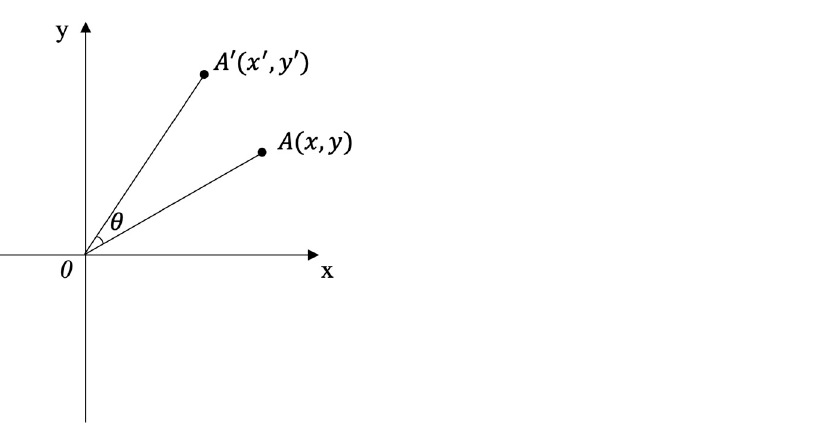
Figure 4. A description of the direction adjustment function. The direction adjustment function is a matrix form of the rotation relationship of A and A (cid:48) . After direction adjustment, the parameters (Formulas (6) to (10)) in the wave potential energy equation and the wave correction equation have multidirectional properties. ϕ g represents gravitational potential energy, where Z is the 3 × 3 template where the central pixel is located, I ( i (cid:48) , j (cid:48) ) is the gray value of the central pixel of the template, g ( i (cid:48) , j (cid:48) ) is the Gaussian weighting function, and MAX is the maximum gray value of the whole image. ϕ v represents kinetic energy, v is central velocity, v q is wavefront velocity, σ is a regulation factor, and the function of wavefront velocity v q is to eliminate speckle noise near the boundary line, which leads to a sharp increase in kinetic energy. The Q template is a 3 × 2 template before the center pixel, and v q is the normalized difference value of adjacent pixels in the Q template. The function of regulation factor σ is to prevent the large area and high gray value area in the image from causing too much kinetic energy and over-segmentation of boundary areas. σ controls the influence of the gray value of the 3 × 3 template on kinetic energy, and the value is between 0 and 1. In the wave correction equation, K is a geometric shape determination function, which shows the geometric distribution of gray values near the point to be measured; C is the gray difference judgment function, which shows the numerical difference in gray values near the point to be measured.